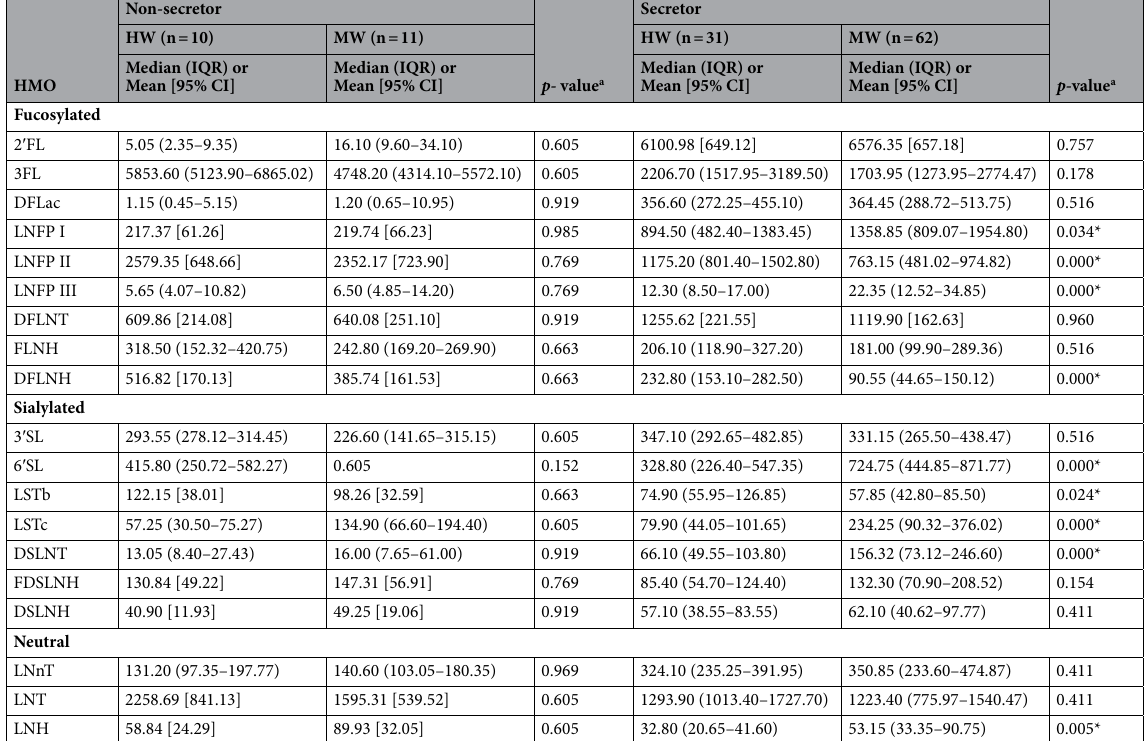
Table 2. Concentration (nmol/mL) of individual HMOs in milk samples according to the Secretor and breast health status (HW, healthy women; MW, mastitis cases) in women. CI confidence interval, IQR Interquartile range, DFLac difucosyllactose, DFLNH difucosyllacto- N -hexaose, DFLNT difucosyllacto- N -tetrose, DSLNH diasilyllacto- N -hexaose, DSLNT diasilyllacto- N -tetraose, FDSLNH fucodisialyllacto- N -hexaose,